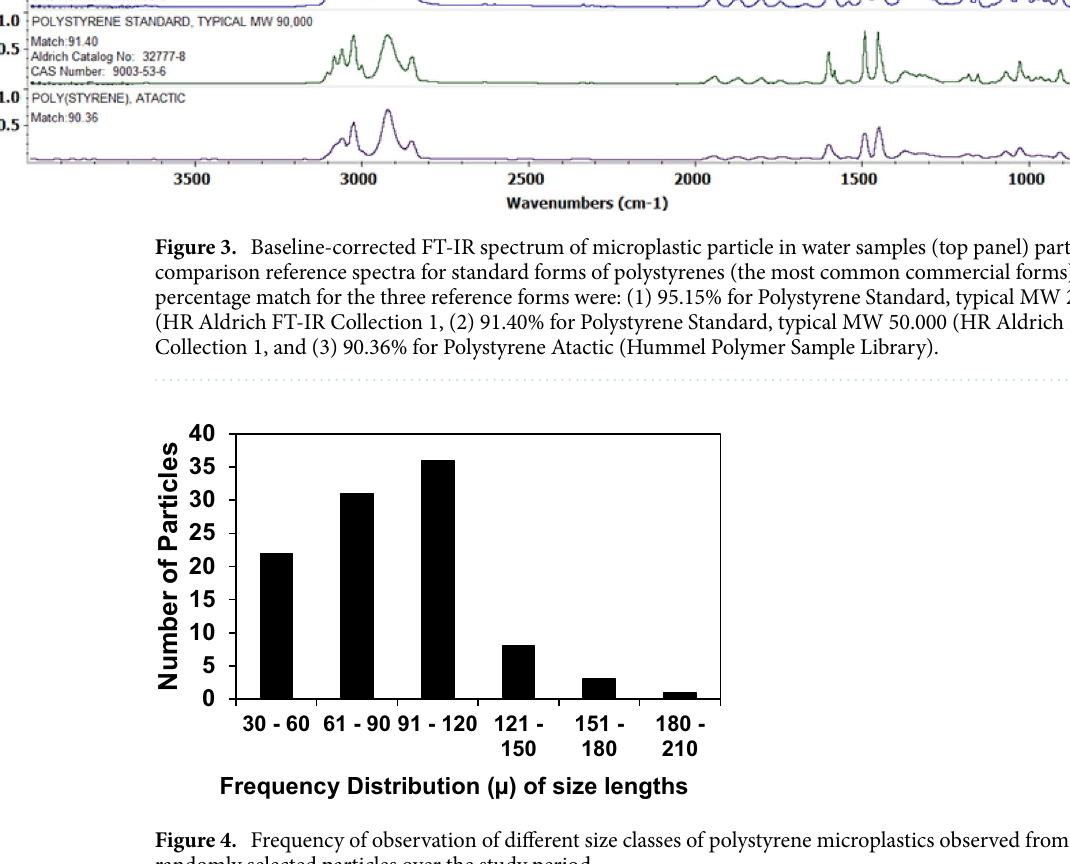
Figure 4. Frequency of observation of different size classes of polystyrene microplastics observed from 100 randomly selected particles over the study